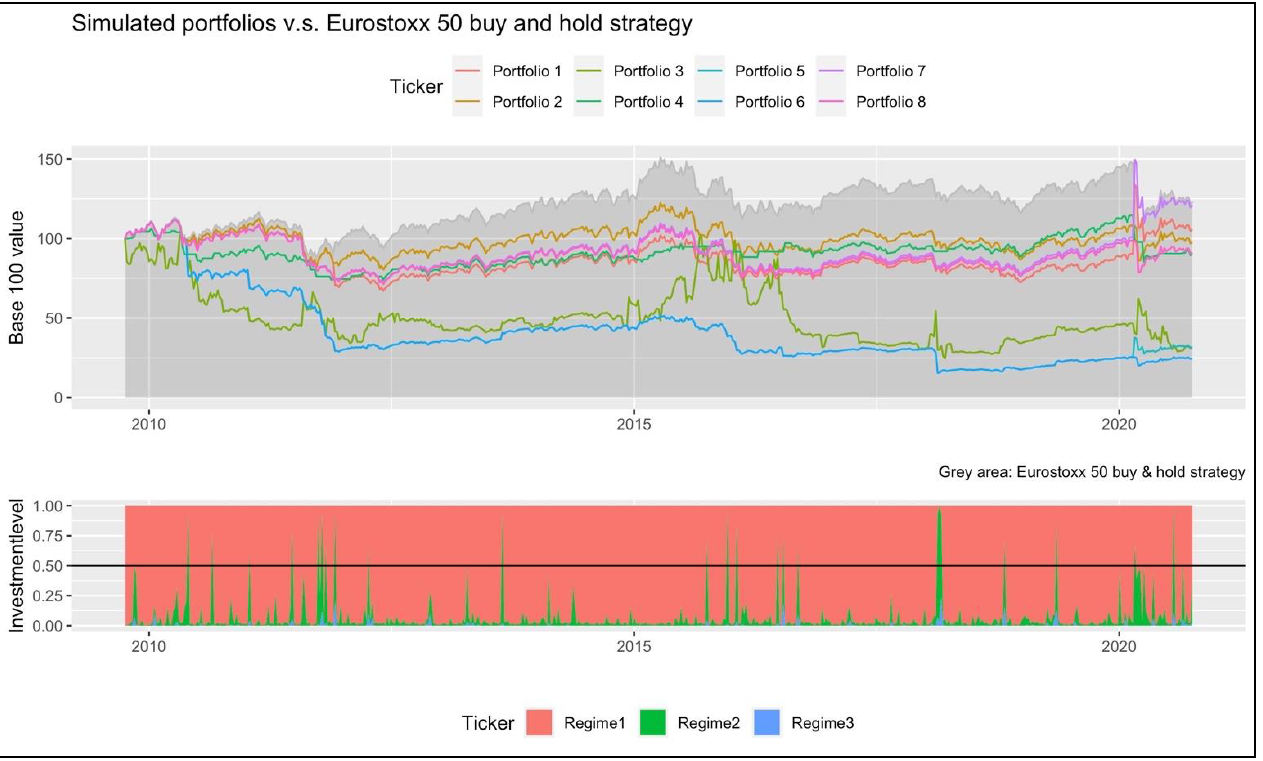
Figure 6. Weekly historical performance of the eight simulated portfolios of Table 2 with a fully invested weighting method ( 𝜔 𝑖 = 100% if 𝜉 𝑠=𝑖,𝑇+1 > 50% ). It presents the historical 9 July 2009 Base 100 value of the eight simulated portfolios (lines) against a buy-and-hold ESTOXX50 strategy (grey area). The historical three-regime MS-GARCH regime-specific forecasted smoothed probabilities ( 𝜉 𝑠=𝑖,𝑇+1,𝑡 ). Methodological note: The eight simulated portfolios include the impact of a monthly stock-trading fee of 0.8% in the mean ESTOXX50 position plus 10% VAT.